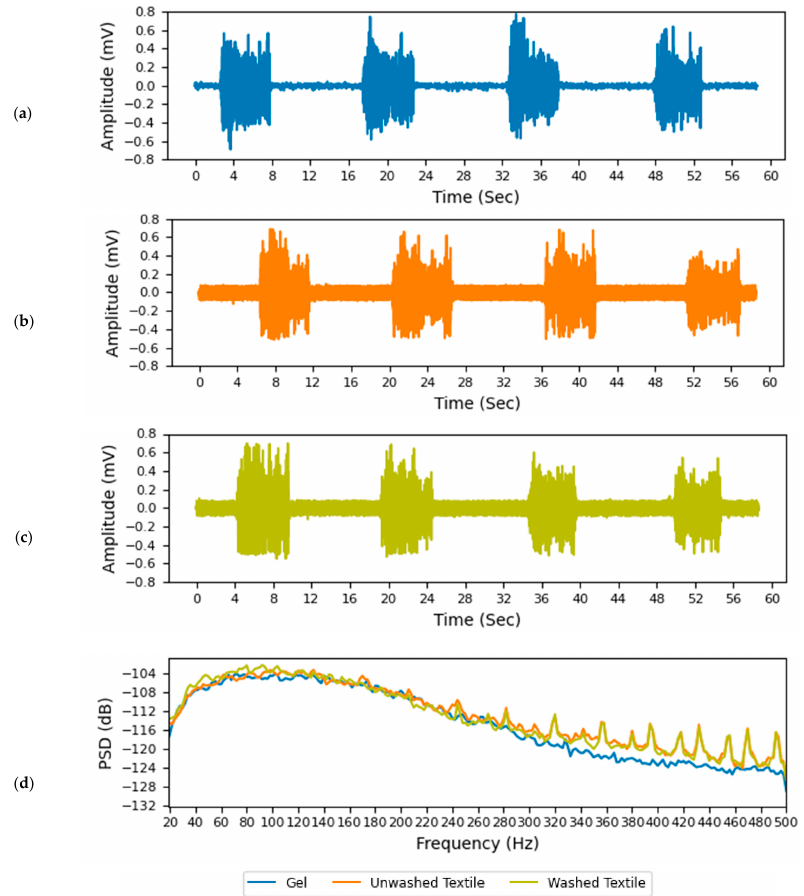
Figure 6. EMG signals collected on channel 2 (Figure 3c) of EMG Textile Sleeve during all finger flexion hand pose using. ( a ) Gel electrodes (2 cm diameter) and ( b ) Unwashed Textile Electrode to compare textile electrodes SNR against the gold standard. ( b , c ) demonstrate the EMG signals collected using the same methods on unwashed ( b ) and 30-times washed ( c ) textile electrodes to assess the possible effects of washing cycles on SNR. ( d ) shows the PSD plots ( a – c ) of gel electrodes, unwashed textile electrodes, and washed textile electrodes. The x -axis range of the PSD plots represents the frequency range of the filtered signal (19–500 Hz).